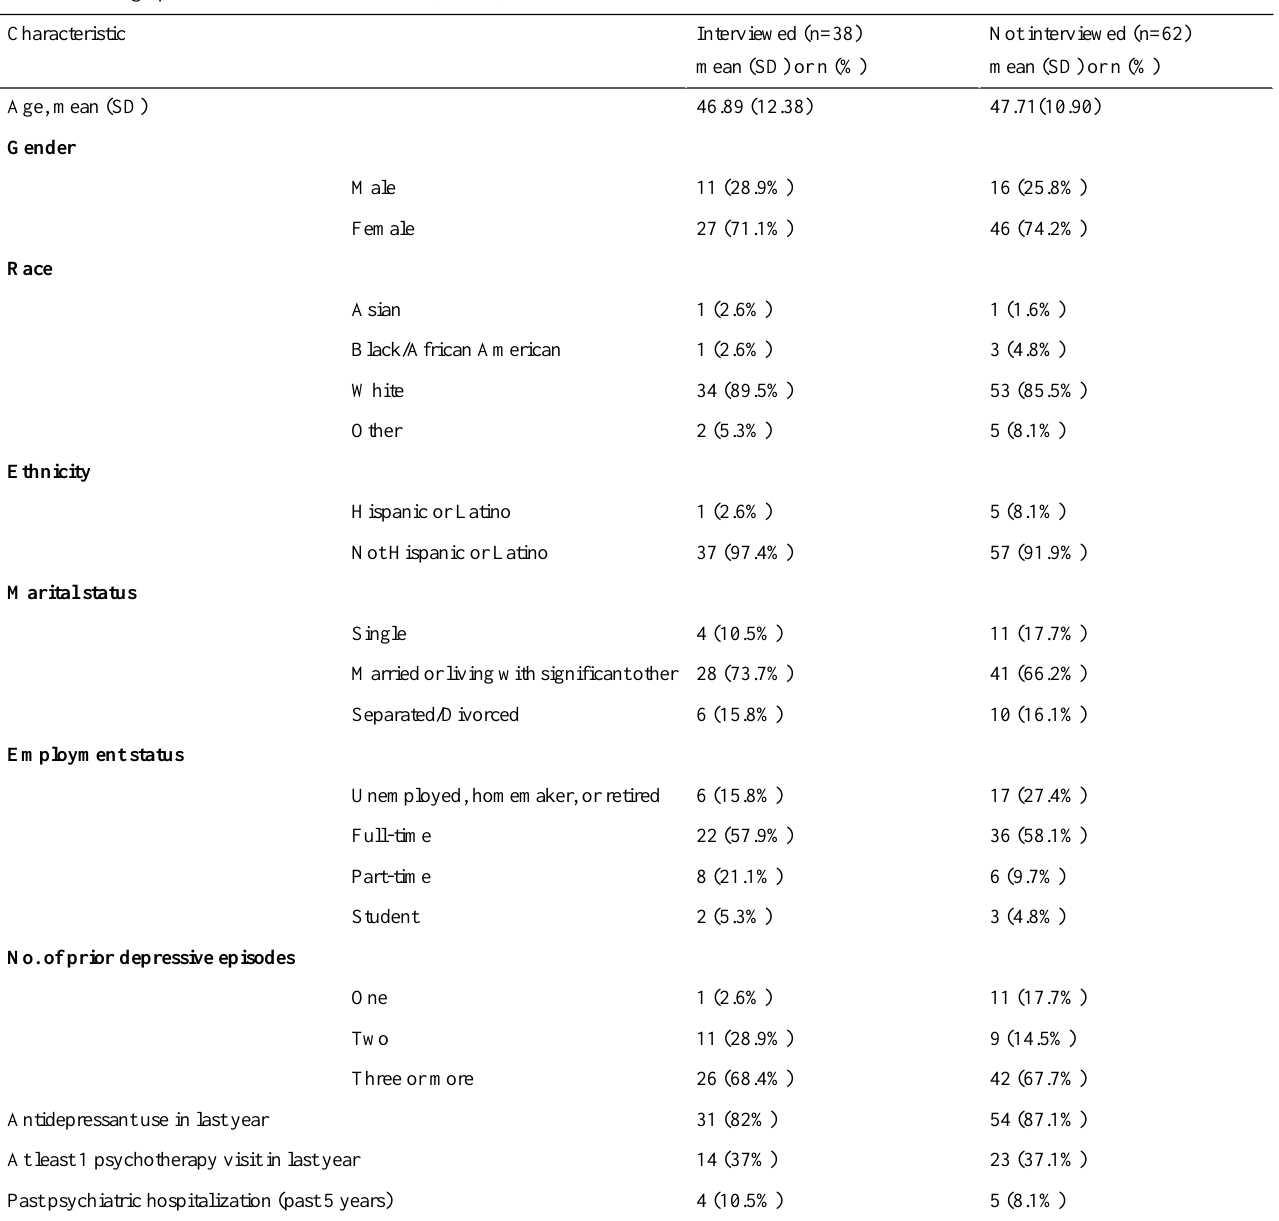
Table 1. Demographic and clinical characteristics